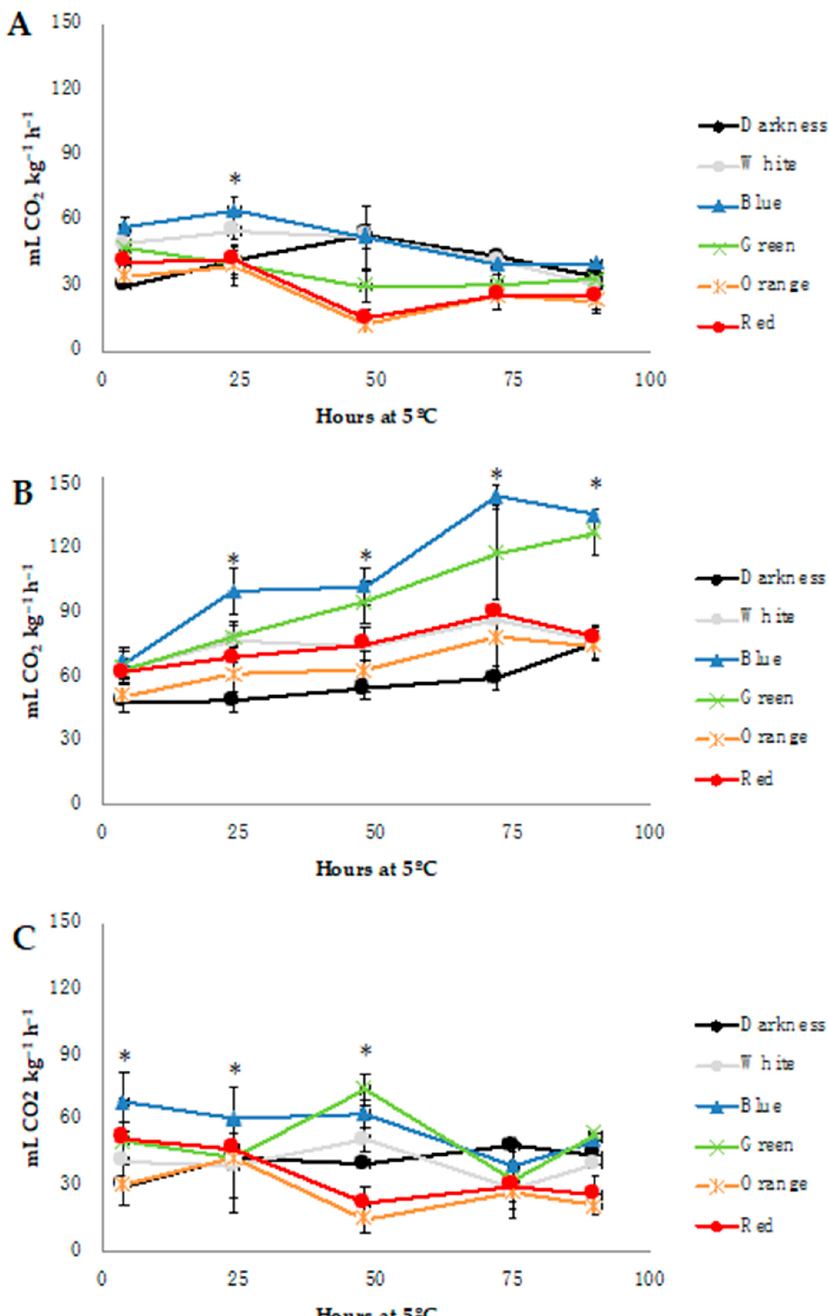
Figure 4. Respiration rate of Brassicaceae (( A ): rocket; ( B ): radish; ( C ): tatsoi) sprouts under different wavelengths for 96 h at 5 ◦ C. * denotes positive significant differences compared to